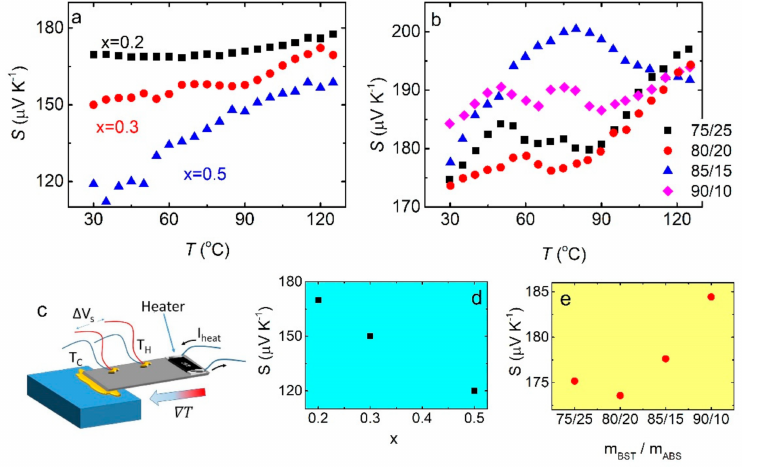
(cid:16) (cid:17) m BST = 80 for various BST compositions. The ex- m ABS 20